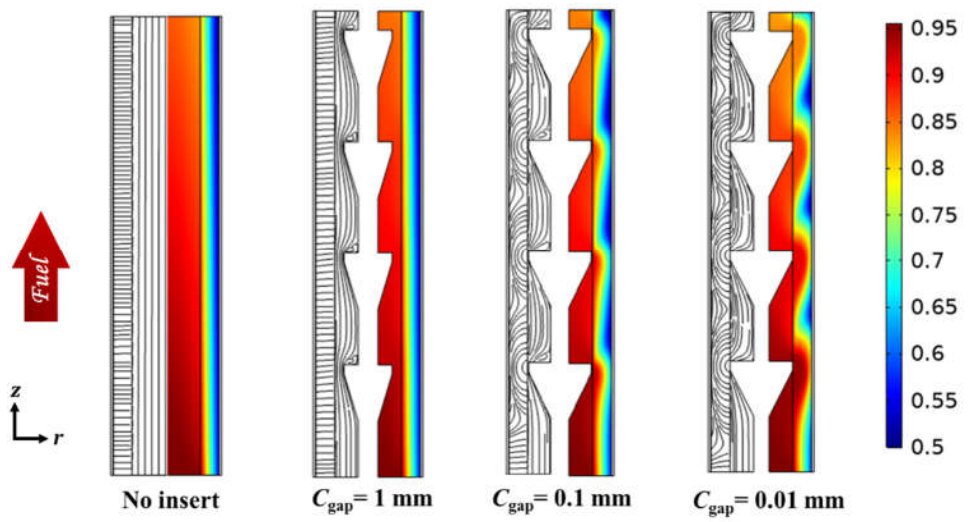
Figure 5. The streamlines ( left ) and CO mole fractions ( right ) of the micro-tubular SOFCs, without an insert and with inserts of three different gaps.